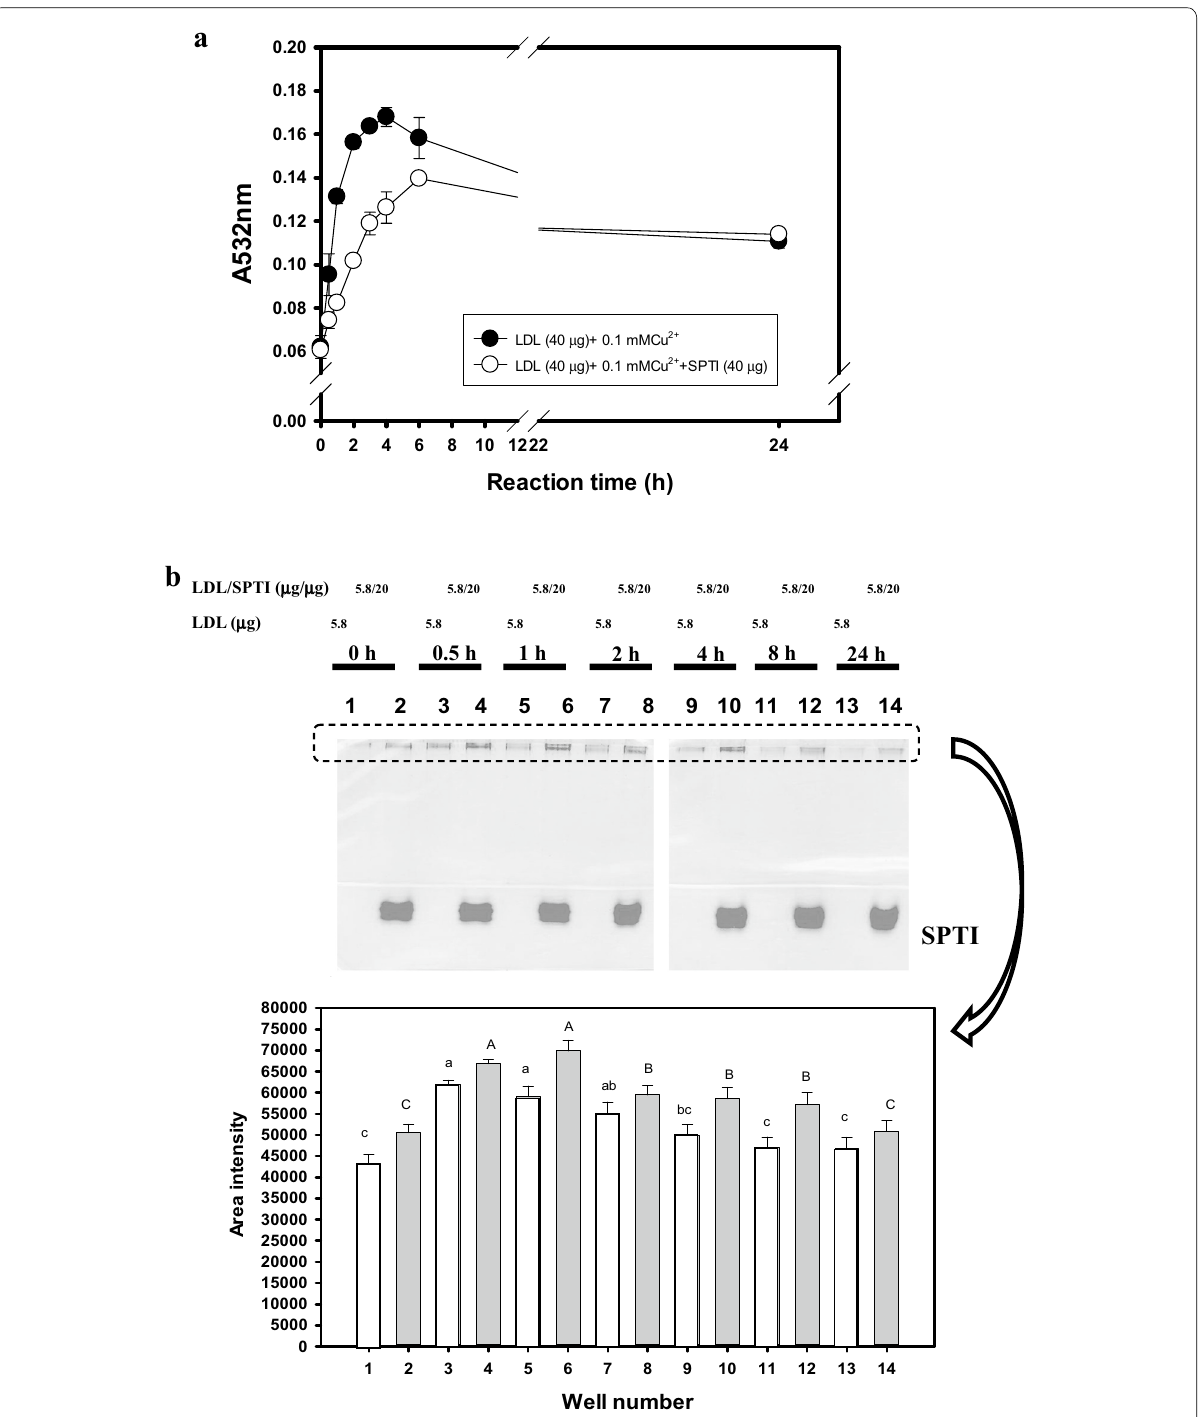
Fig. 1 a Effect of sweet potato trypsin inhibitors (SPTIs) on 0.1 mM Cu 2 + ‑mediated low‑density lipoprotein (LDL) oxidation during 24‑h reactions evaluated by TBARS methods, and b during Cu 2 + ‑mediated LDL oxidation, effects of SPTIs on LDL or oxLDL binding were evaluated by protein stains in native PAGE gels with two layers of separation gels. The selected square frame was quantified by a Syngene G:bBOX imaging system (Syngene, UK). Values were presented as mean SD and were analyzed using one‑way ANOVA, followed by a post hoc Tukey’s test for multiple ± comparisons. The different marked symbols (LDL only, lowercase; LDL/SPTIs model, uppercase) in each bar were significantly different ( P <